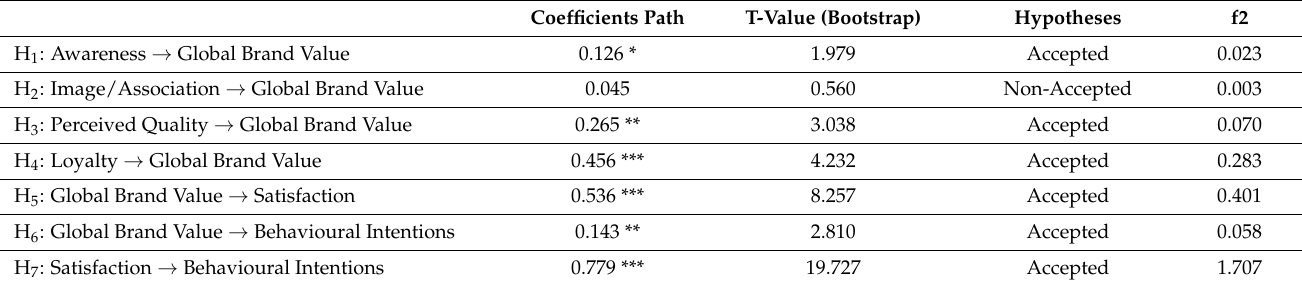
Table 6. Structural model results.